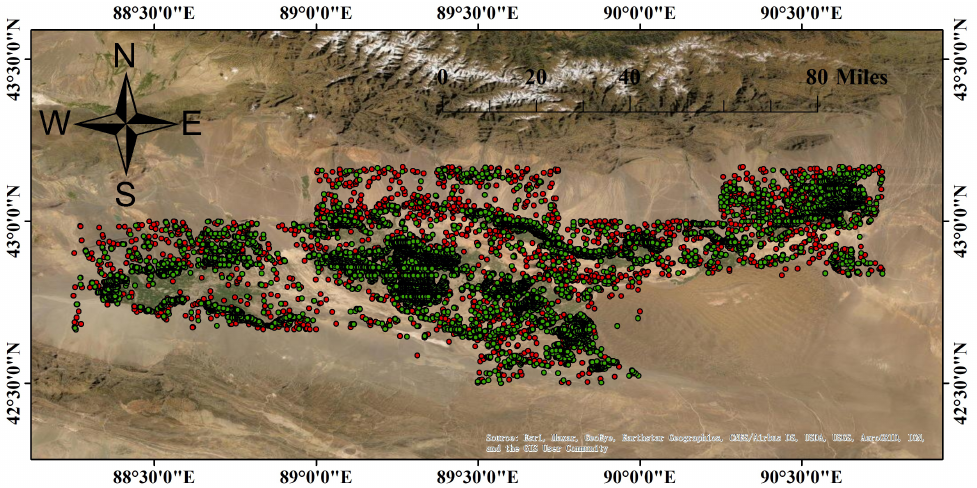
Figure 11. Karez shaft of the whole Turpan Basin predicted by YOLOv5 (including solid red and green points with black boundaries, red points represent the false karez extracted by post-preprocessing operation, and the green points are the karez shafts retained after the post-processing step), and the base map is World-Imagery in